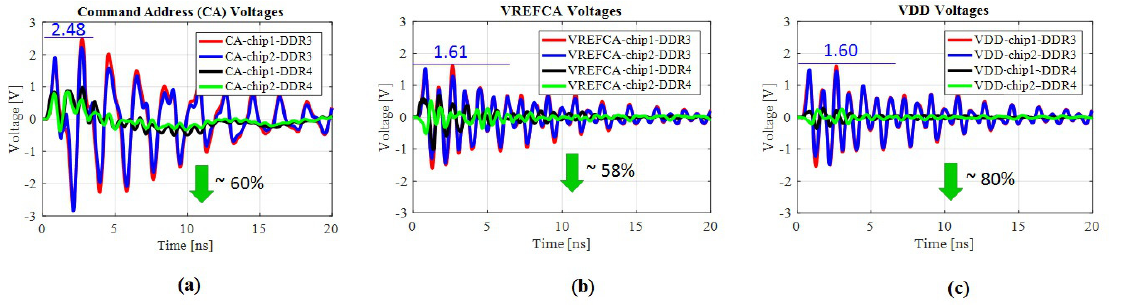
Figure 13. Comparison of induced voltages for most sensitive traces of DDR3 and DDR4 nets across all SODIMM chip positions: ( a ) CA; ( b ) VREFCA; and ( c ) VDD.